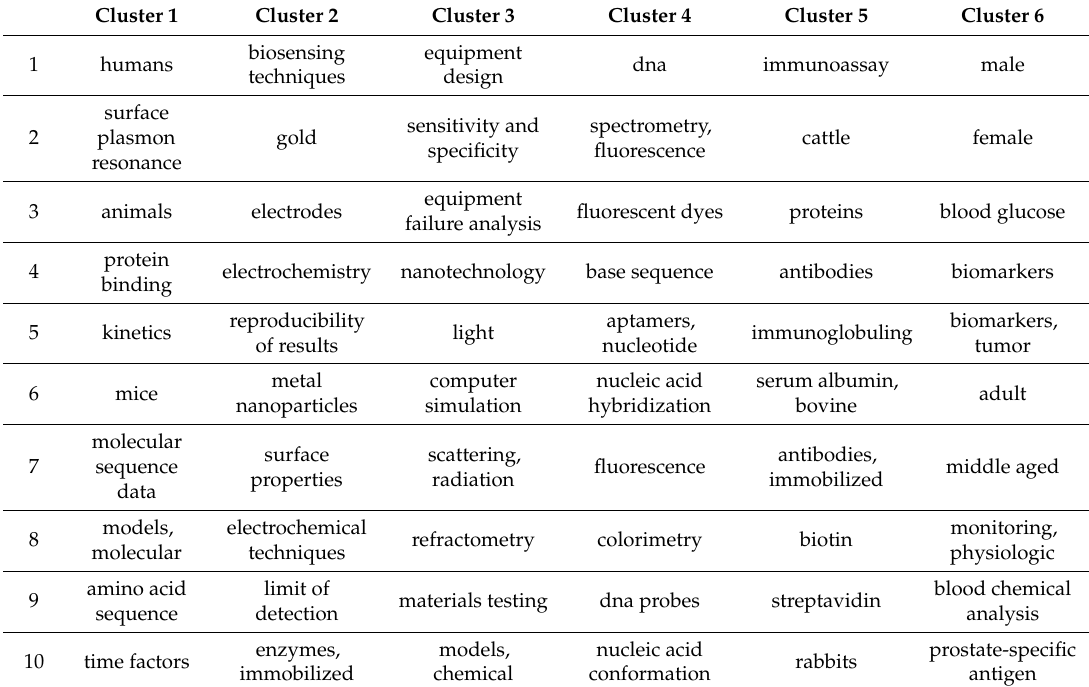
Table 5. Top 20 terms in each of the clusters that are formed with co-occurrence analysis of MeSH Terms.